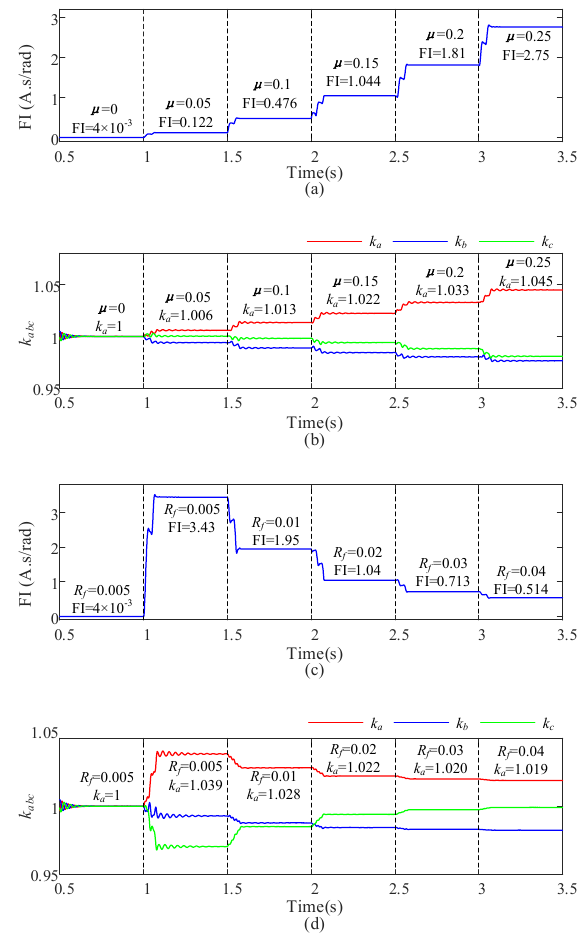
Figure 9. Fault detection index and fault phase location indexes under different fault severity. ( a ) Detection index with different μ when R f = 0.02; ( b ) location indexes with different μ when R f = 0.02; ( c ) detection index with different R f when μ = 0.15; ( d ) location indexes with different R f when μ =